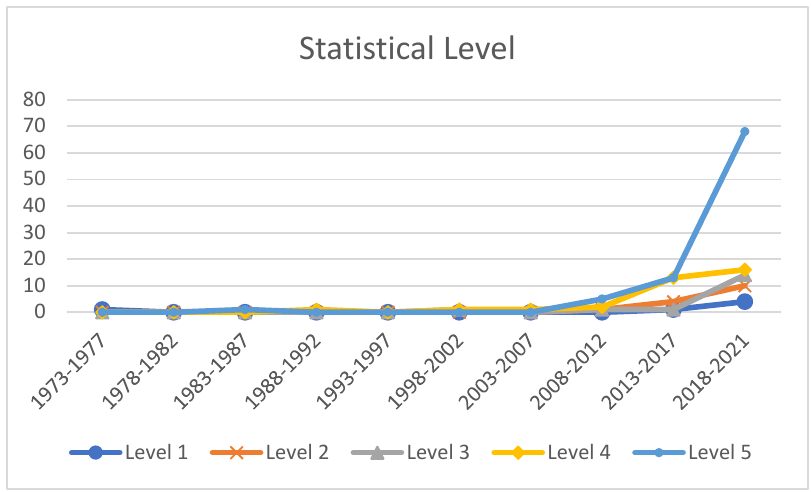
Figure 6. Trend of Statistical Level by Five-Year Interval during 1973 – 2021 (n = 159).